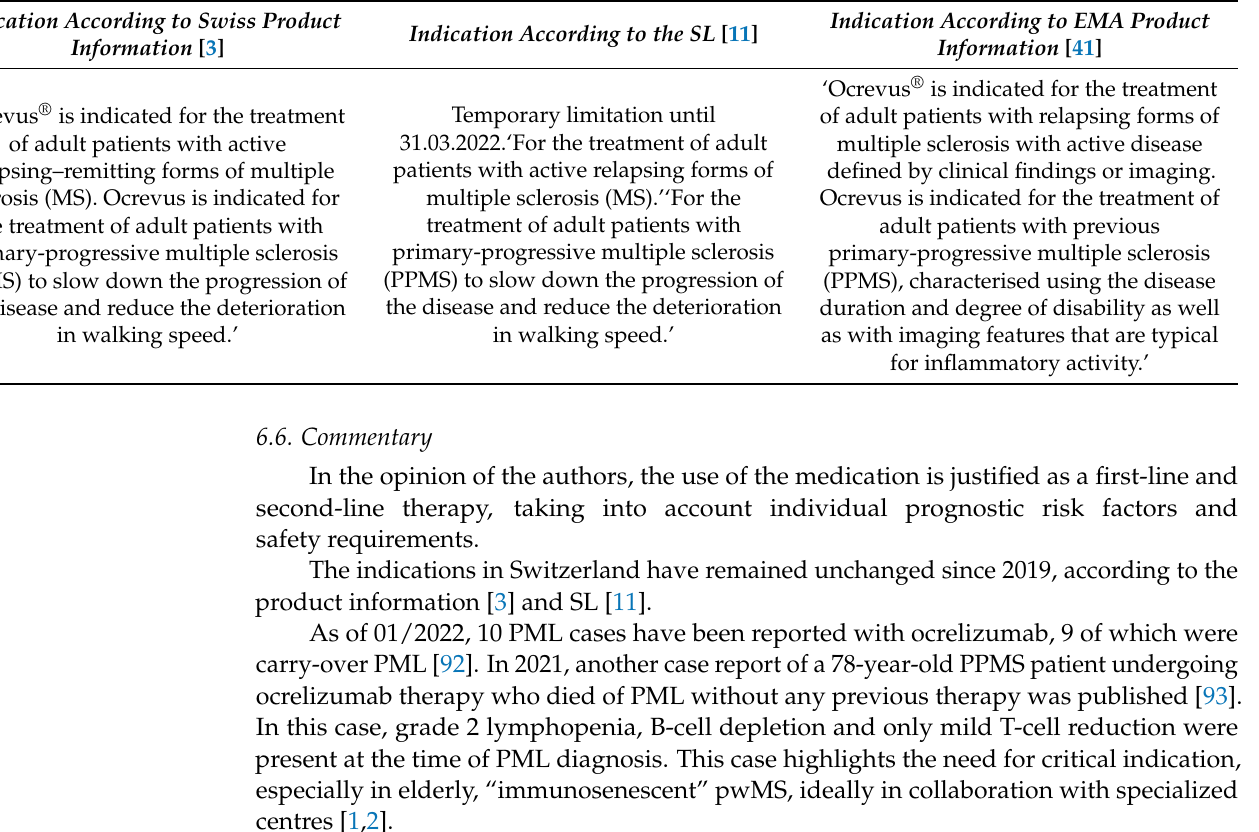
Table 13. Ocrelizumab (Ocrevus ®